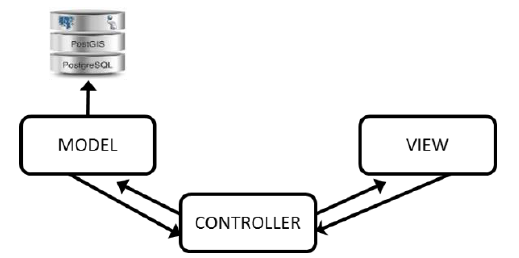
Figure 4 . The MVC design pattern general block